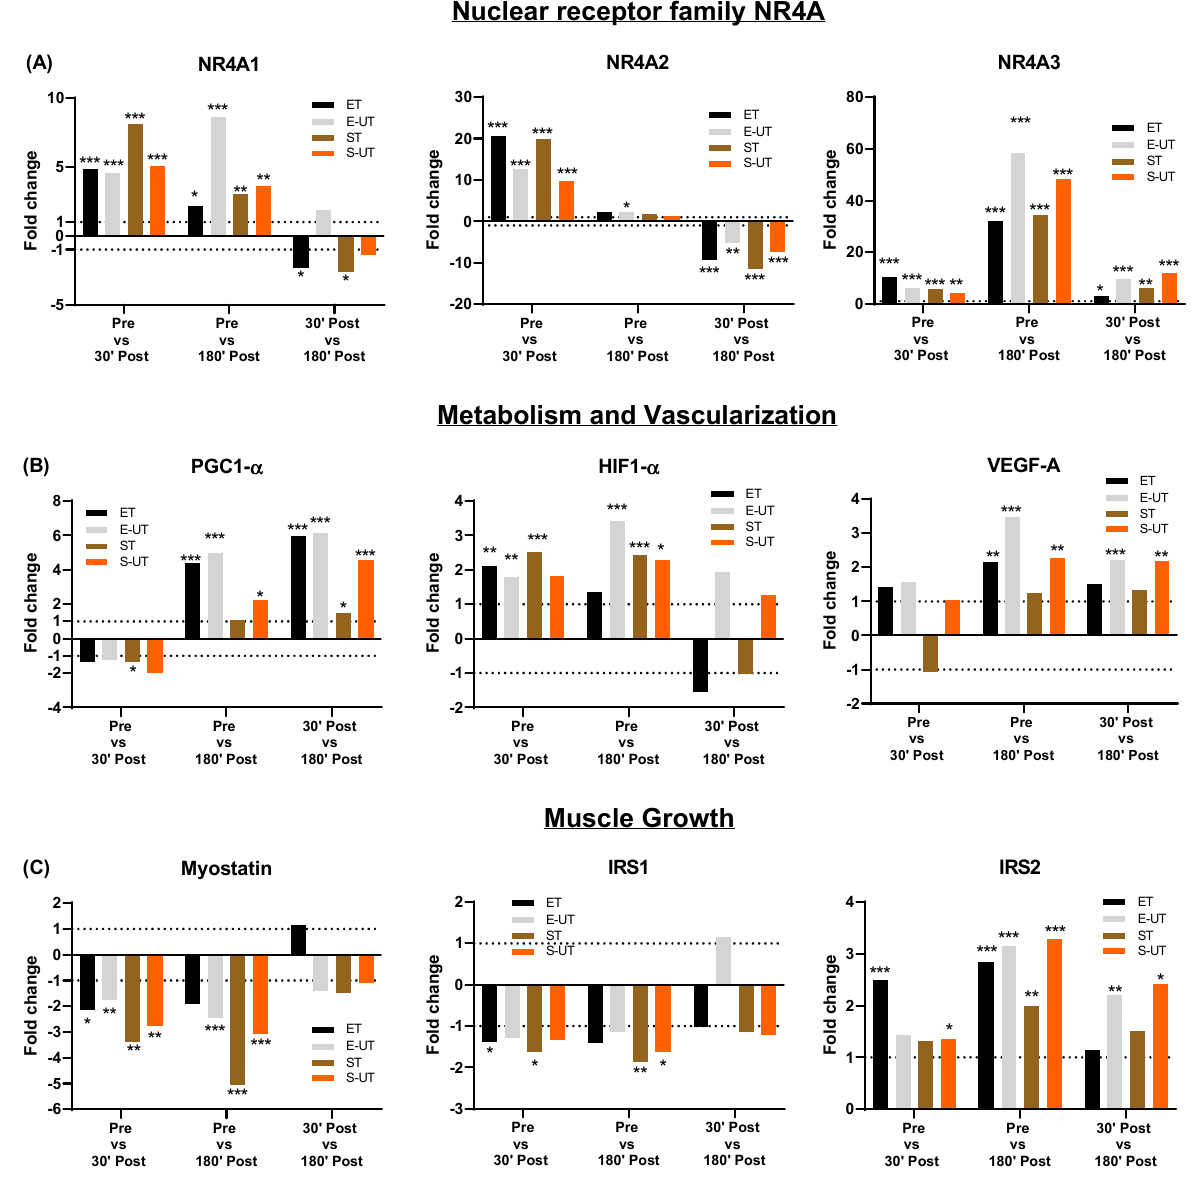
Figure 3. Fold change of genes involved in ( A ) nuclear transcription (NR4A family), ( B ) metabolism and vascularization (PGC1- α , HIF-1 α and VEGF-A) and ( C ) muscle growth/structure (myostatin, IRS1 and IRS2) at Pre (baseline) vs. 30 ′ Post, Pre vs. 180 ′ post and 30 ′ Post vs. 180 ′ Post. The respective genes were selected after pathway analysis of exercise related metabolic pathways. Dotted lines signify the fold-change of 1 and − 1. Significance level was set at * p ≤ 0.05, ** p ≤ 0.01, *** p ≤ 0.001.